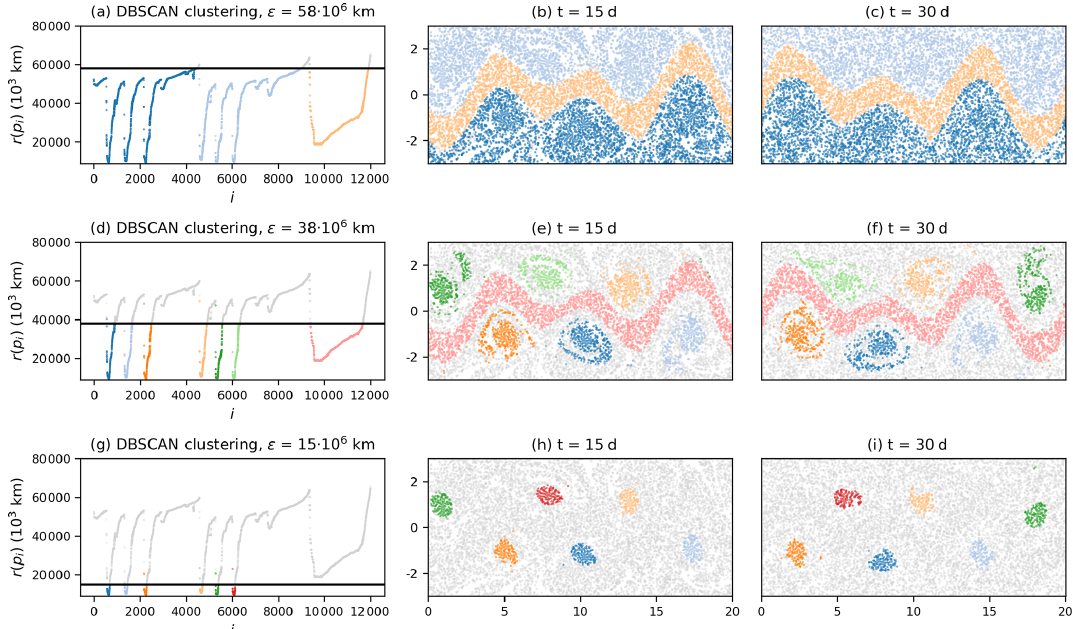
Figure 2. Result of the OPTICS algorithm applied to the direct embedding of the trajectories. (a) , (d) and (f) show the reachability plot, with different DBSCAN clustering results indicated by the black horizontal line. The corresponding clustering results of each choice of DBSCAN parameter (cid:15) is shown on the right of the reachability plots for different times. Grey particles correspond to noise. Axis units in the centre and right column are in 1000km.